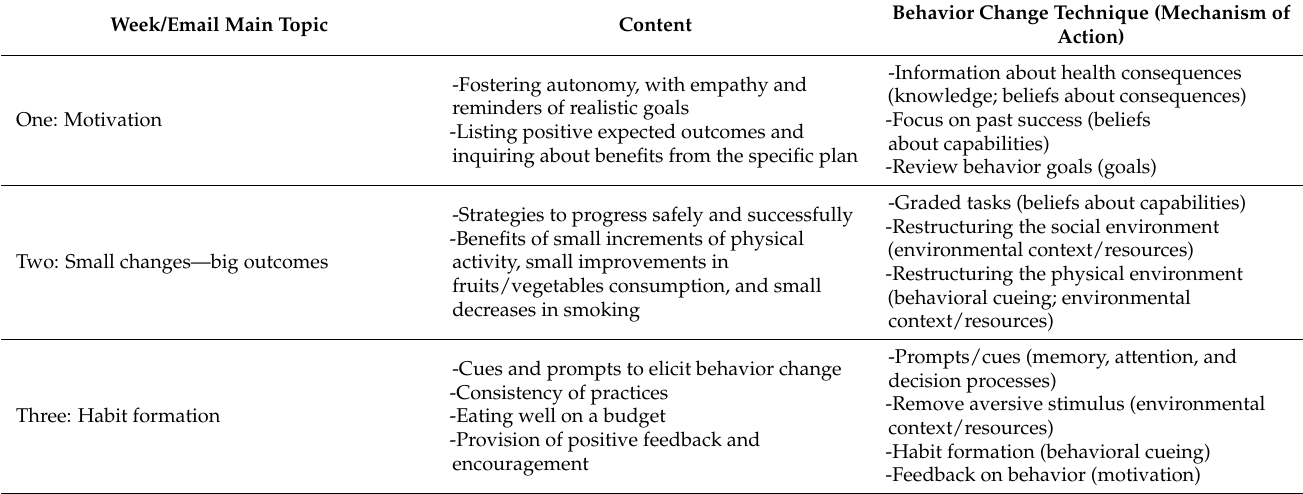
Table 2. Main topic and overall content, as well as behavior change techniques and respective mechanisms of action used in each individualized